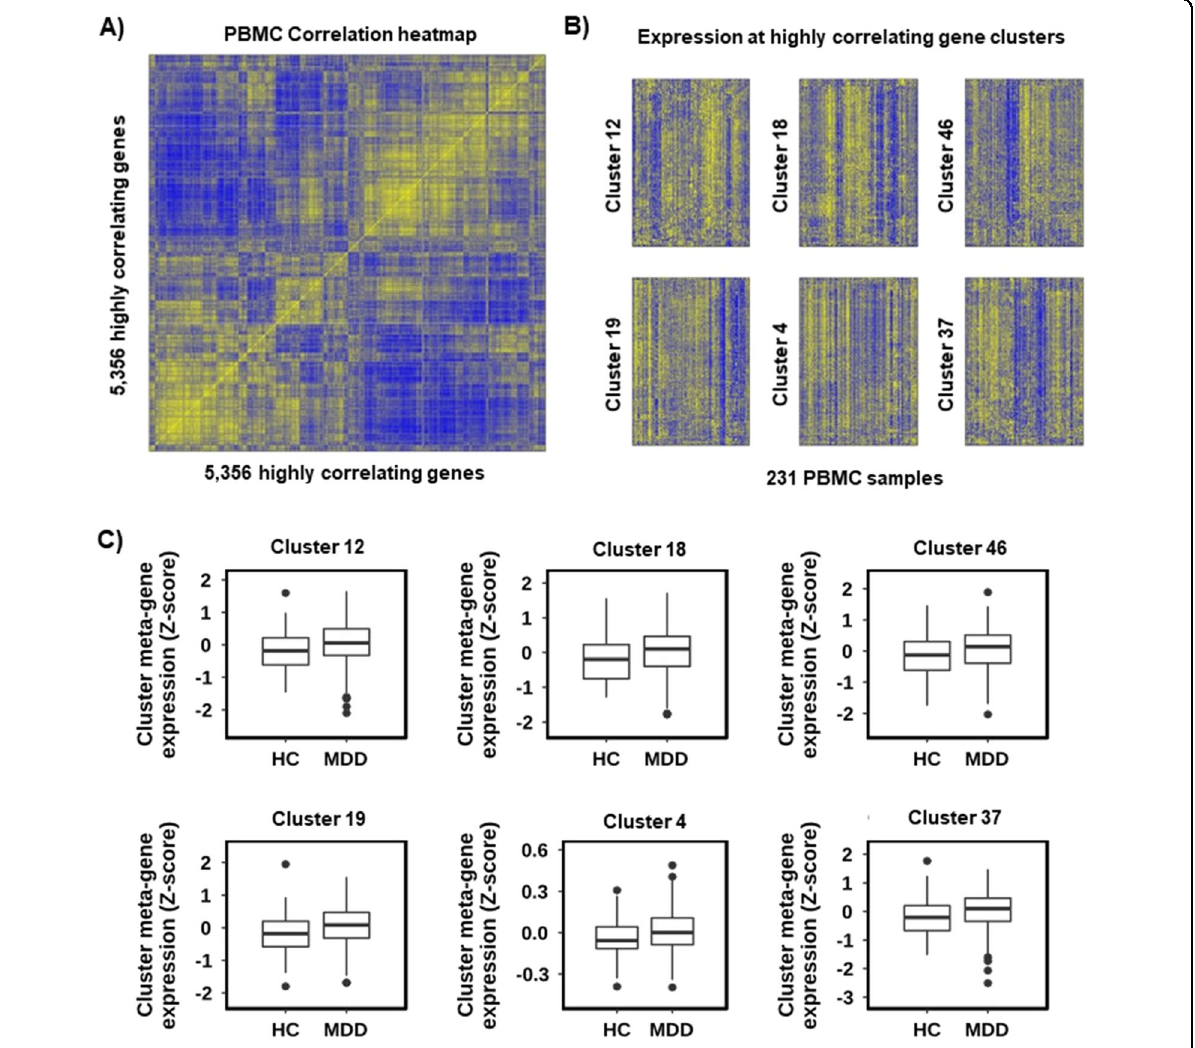
Fig. 3 There is no evidence for clusters of highly correlating genes that are altered in MDD compared to HC. A Gene co-expression heatmap highlighting the presence of clusters of highly correlating genes in PBMC data. The x and y -axis show the 5356 highly correlating genes. The colour intensity indicates the spearman correlation value between two given genes with blue as low and yellow as high. To highlight the presence of co- expression clusters the heatmap has been hierarchically clustered on both axes using Spearman distances, with UPMGA agglomeration and mean reordering. B Gene expression heatmaps for six gene co-expression clusters, highlighting the consistency between the expression pattern of all genes within a cluster across all 231 samples. Samples are given by column and cluster genes by row. Colour intensity indicated row scaled ( z -score) gene expression, with blue as low and yellow as high. C Gene expression boxplots for the six clusters with the lowest p -value ( T -test) for HC vs MDD. Showing sample group on the x -axis and the cluster metagene expression (mean z -score) on the y -axis. All clusters are non-signi fi cant with adjusted p